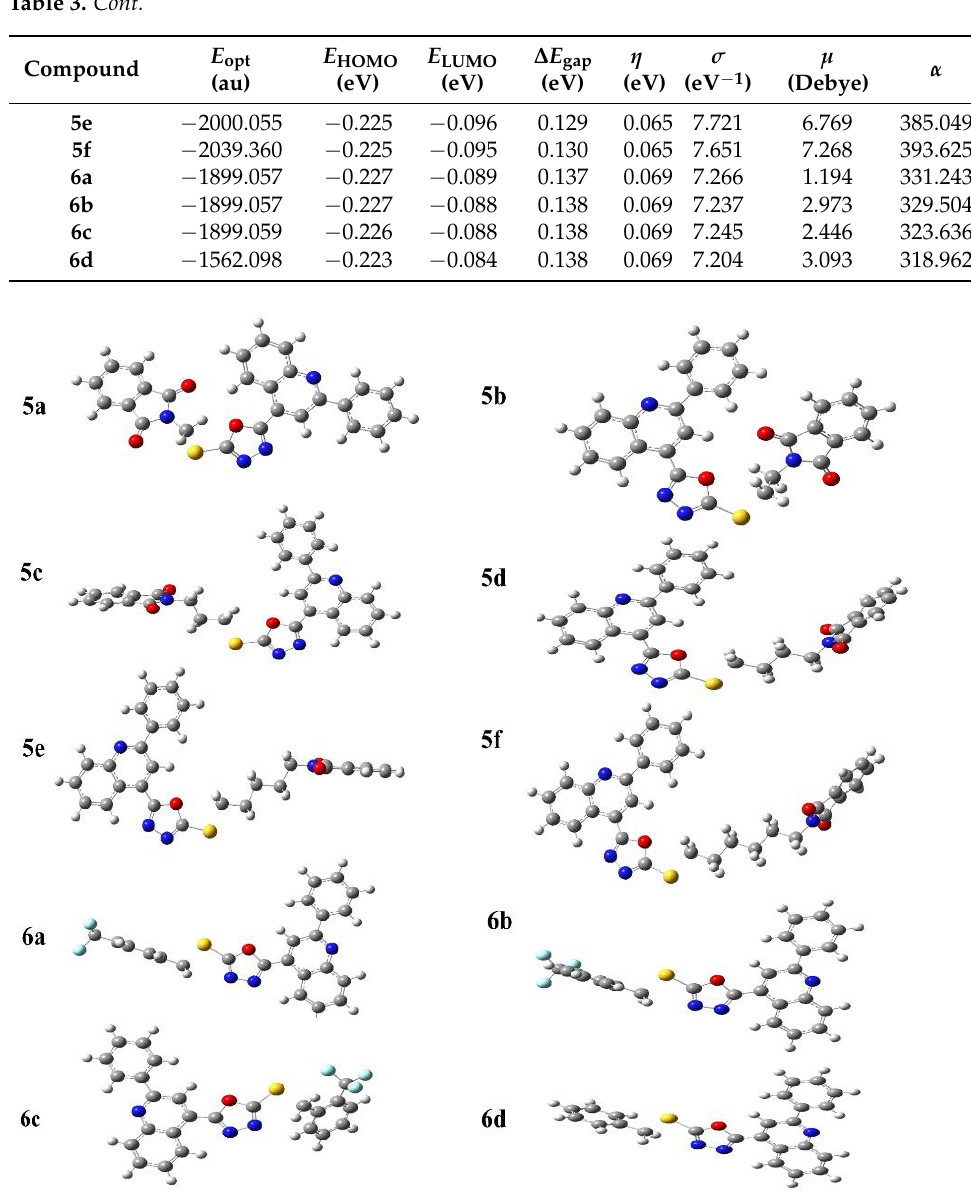
Figure 6. Optimized structures of compounds 5a – f and 6a – d .